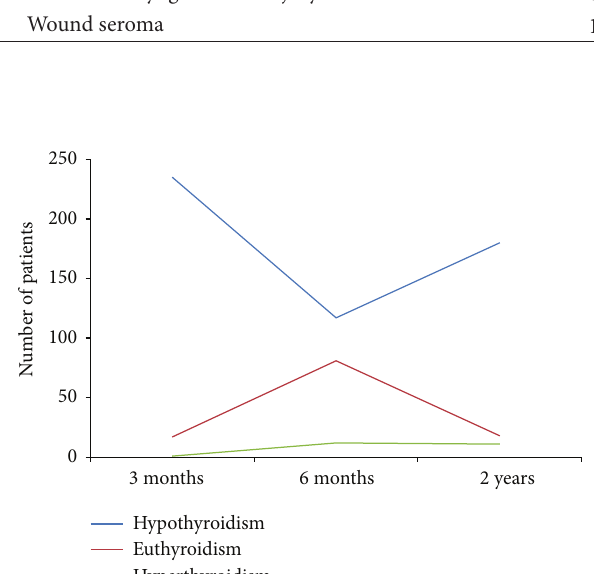
Figure 2: Pattern of postoperative thyroid function changes over time after subtotal thyroidectomy in Graves’